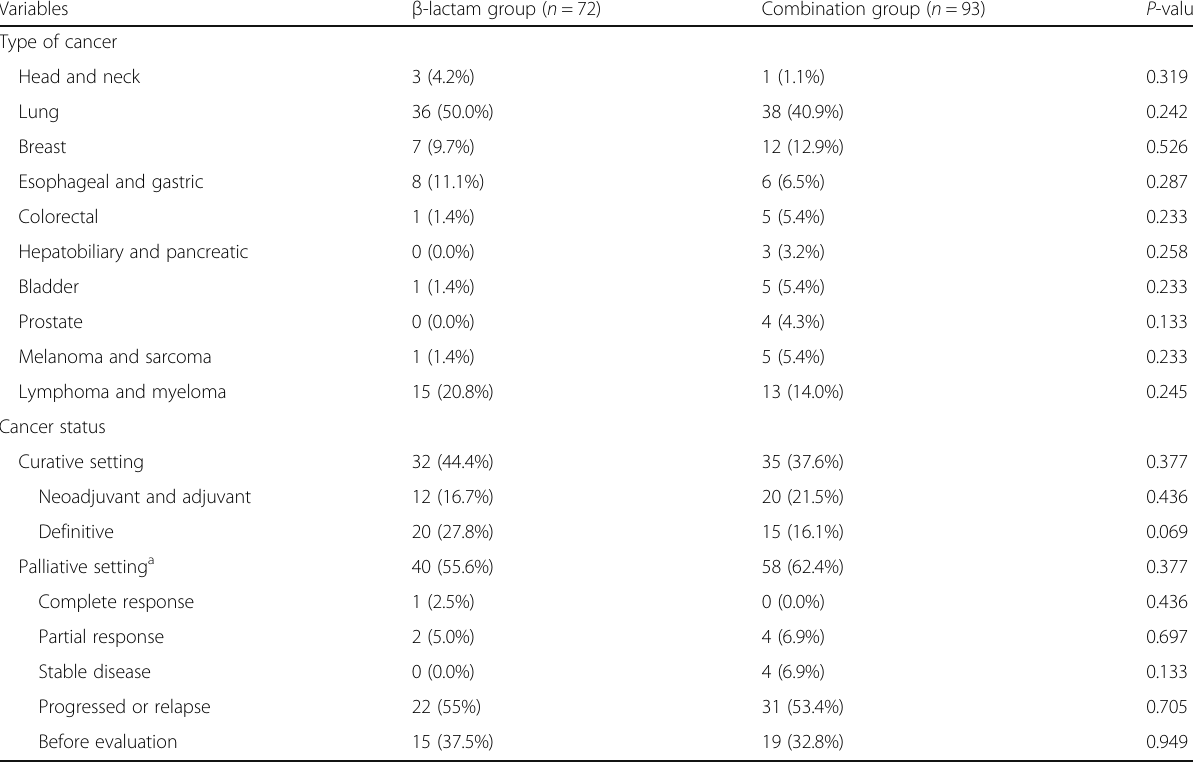
Table 2 Types and status of cancers in patients with neutropenic pneumonia